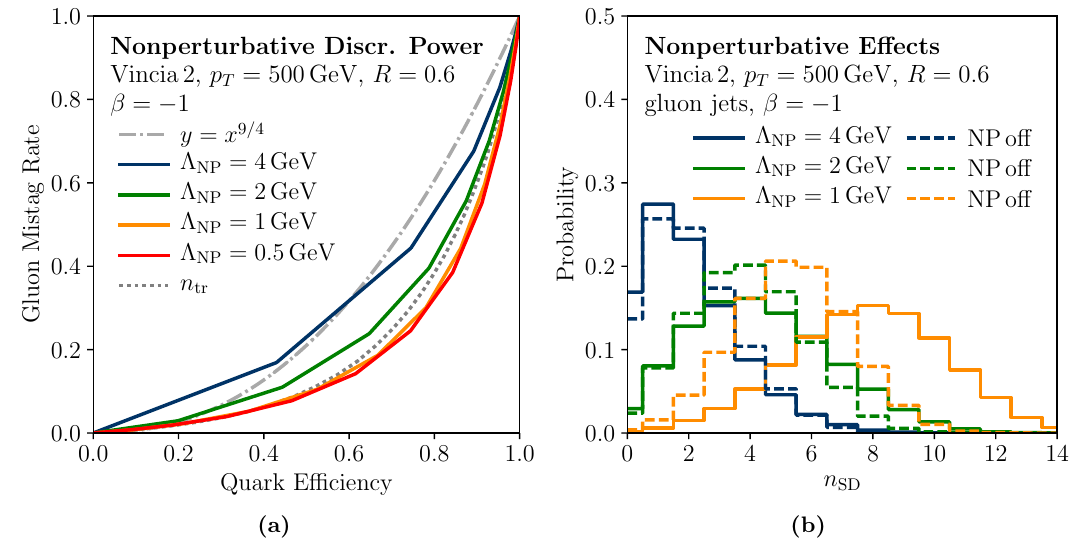
Figure 10. (a) Discrimination power of soft drop multiplicity as a function of (cid:3) (cid:18) cut = 0, and z cut computed from eq. (3.20). (b) Impact of hadronization and underlying event in Vincia on gluon